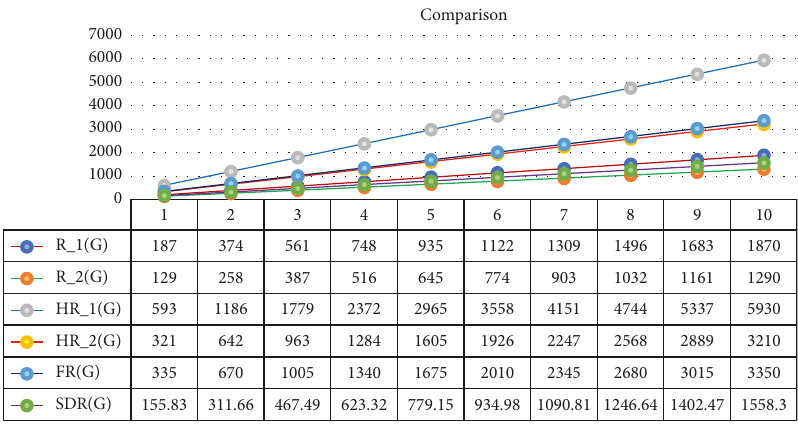
Figure 5: Comparison of R